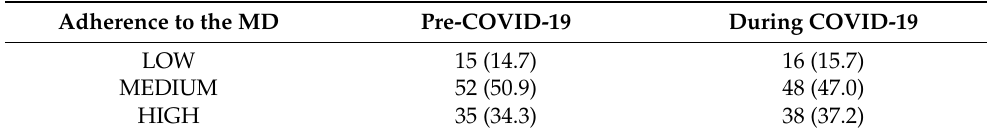
Table 3. Adherence to the MD.